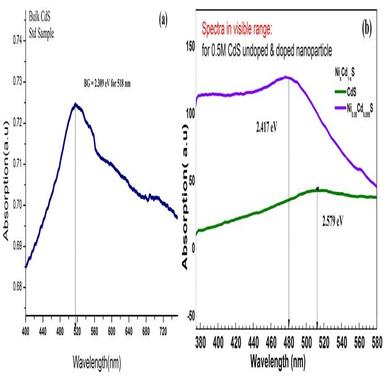
(a) UV–vis spectra for (a) Bulk CdS(Standard Sample), and (b) for 0.5M CdS & Ni-doped CdS NP.